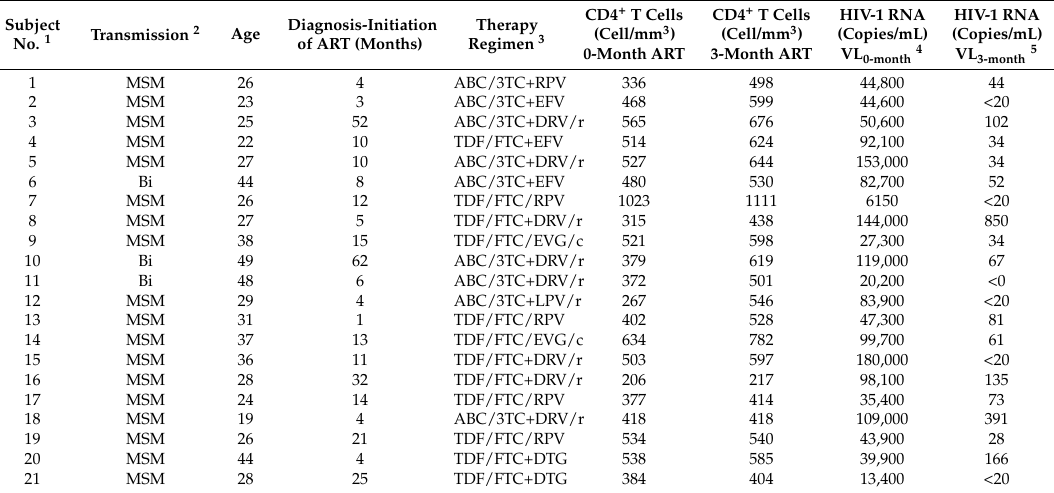
Table 1. Clinical characteristics of the HIV patient